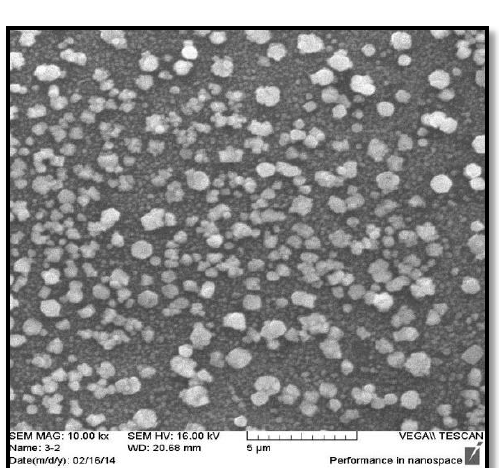
Fig.8: (SEM) micrograph images for Z :S . 0.75 0.25